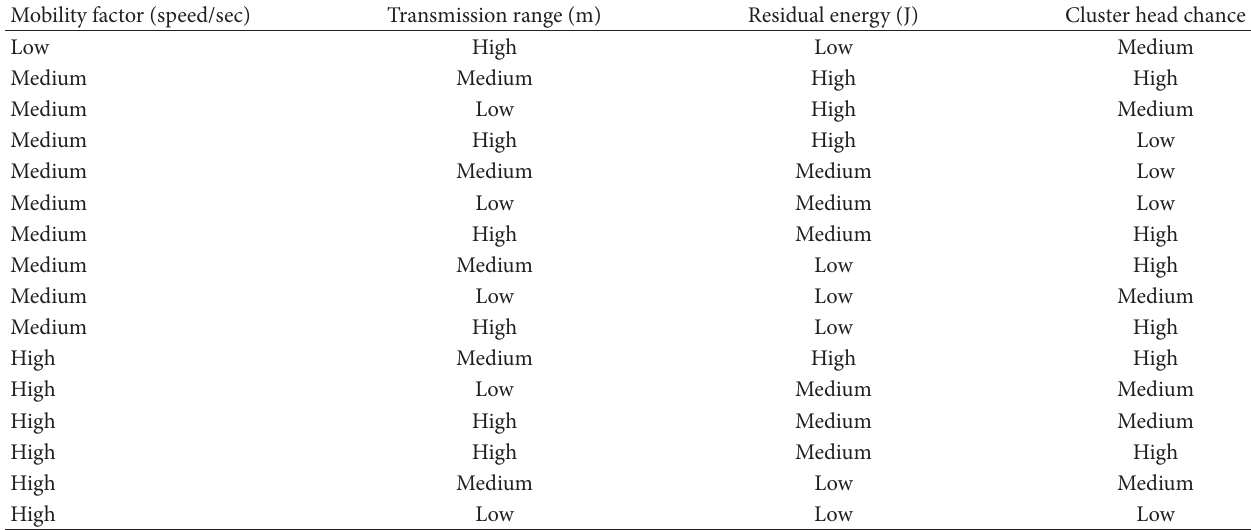
Table 1: Fuzzy if-then mapping rule for cluster head chance.